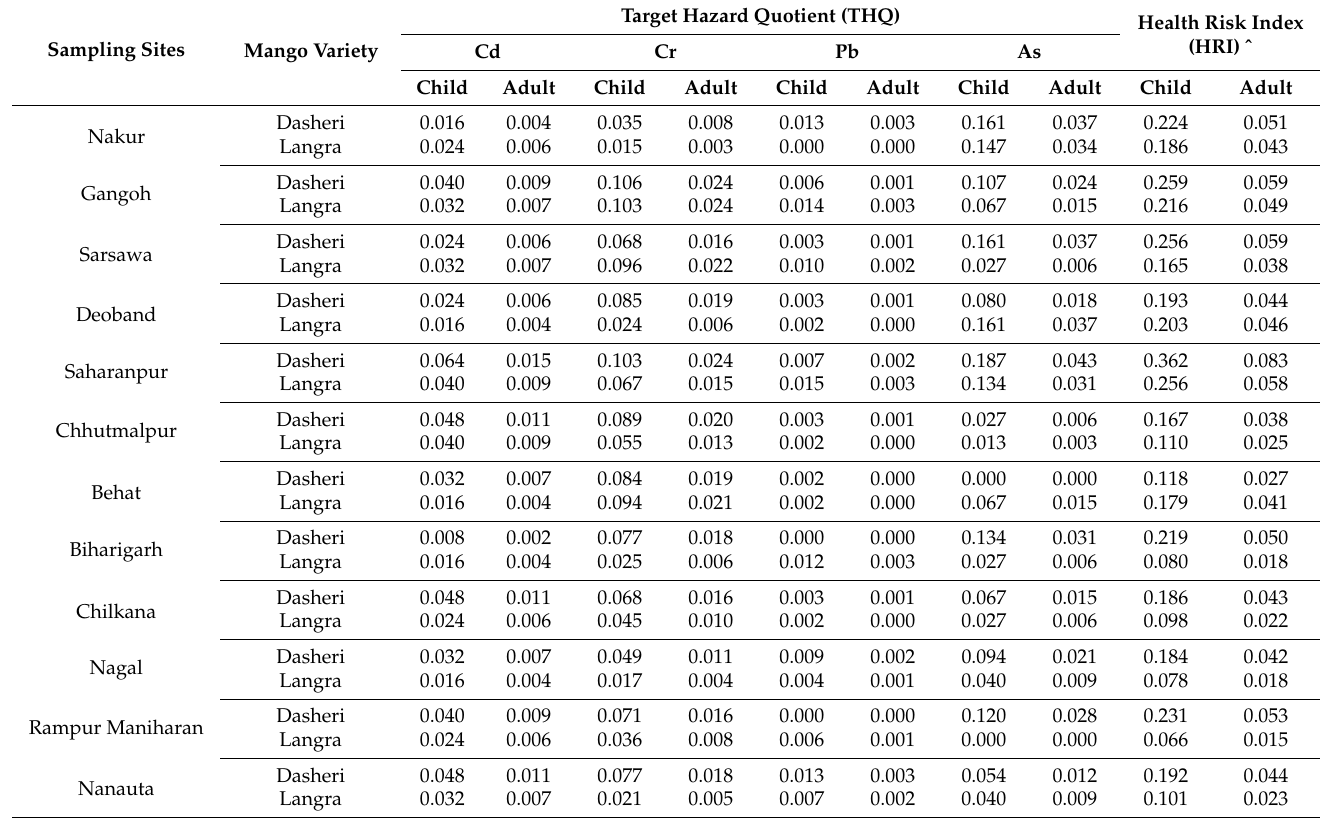
Table 4. Health risk index of heavy metal contents in selected mango fruit ( M. indica ) variety samples collected from Saharanpur district, Uttar Pradesh,